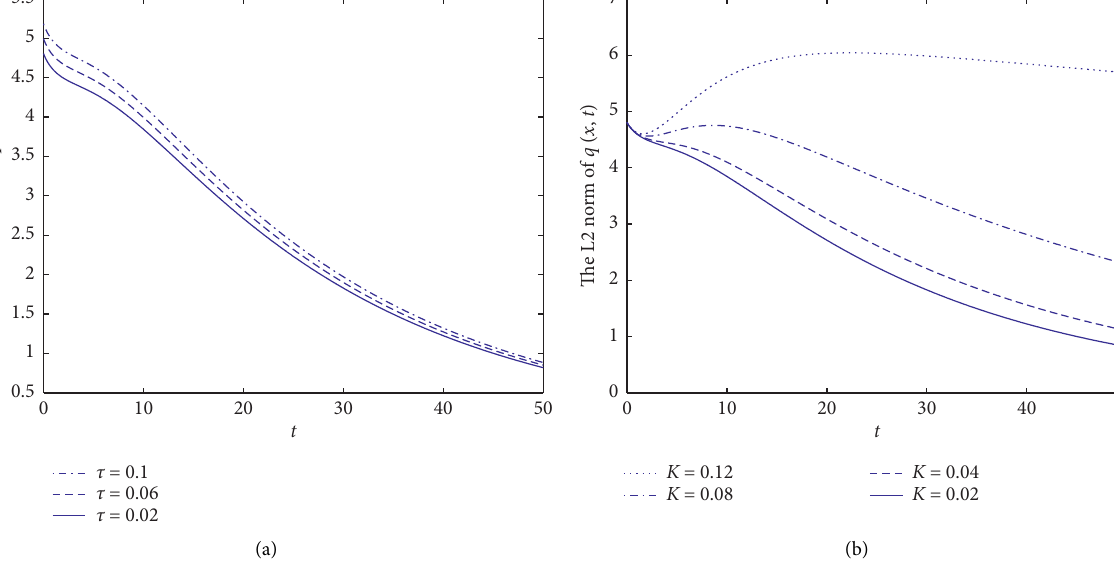
Figure 3: (a) The L 2 -norm of q ( x, t ) vs. time with b ( x ) � x / π − 1, q ( x, s ) � ( 1 + s ) sin ( x /2 ) , α � 0 . 4 , β � 0 . 1 , κ � 0 . 02 and for different values of τ . (b) The L 2 -norm of q ( x, t ) vs. time when α � 0 . 4 , β � 0 . 1 , τ � 0 . 02, and for different values of κ